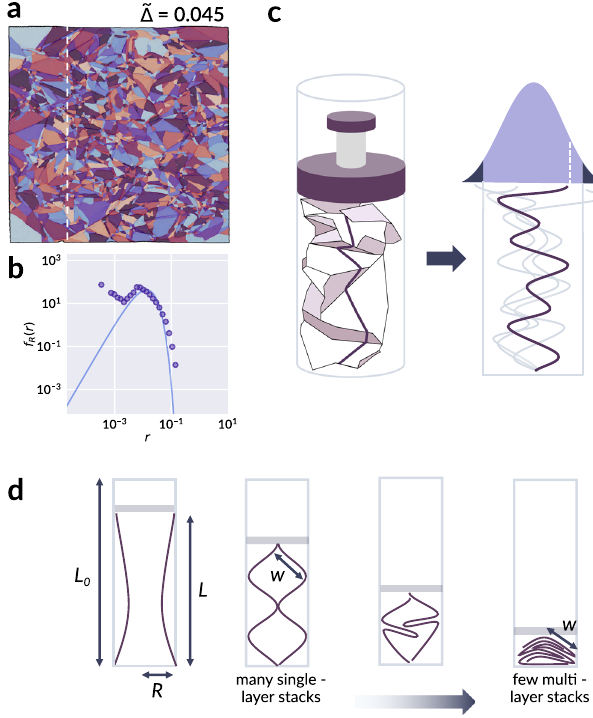
Fig. 6 A folded cross-section considered as a one-dimensional random walk. a A sample segmented sheet with dashed line indicating a vertical cross section. b The distribution of segment lengths from all such cross- sections of the sheet in a ( fi lled points), with Eq. (15) plotted as a solid curve. No additional fi t is performed; the value of the shape parameter a which appears in Eq. (15) is uniquely determined from Eq. (8) and the best fi t τ to the facet area distributions. c A schematic of the analog between the folding of a one-dimensional strip in an axially con fi ned sheet and a one- dimensional random walk whose time axis is extended vertically for clarity. The fi lled curve represents the distribution of the walker ’ s fi nal displacement, with darker shaded regions denoting the fraction of walks which lie outside a given con fi nement. d Simpli fi ed illustration of one- dimensional folding which facilitates a geometric estimate of the critical con fi nement w , further detailed in Supplementary Note